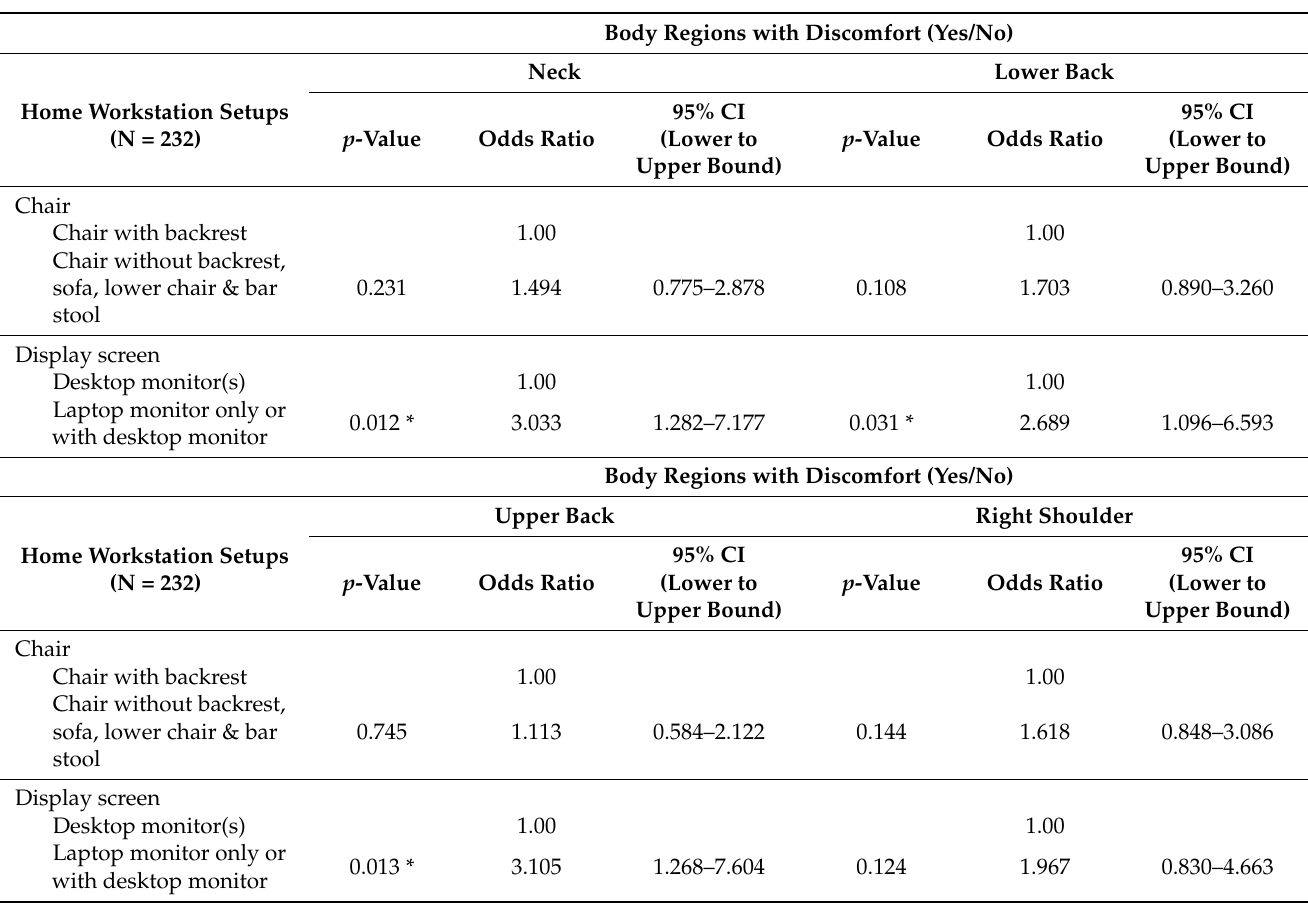
Table 9. Summary of multivariate logistic regression analyses for home workstation setups and neck, lower back, upper back, and right shoulder musculoskeletal